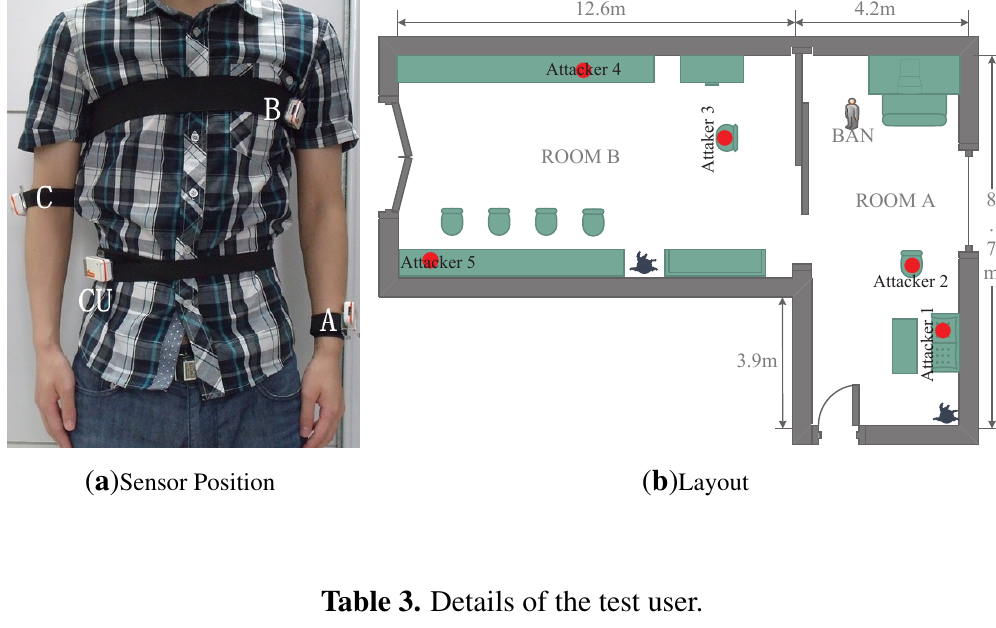
Table 3. Details of the test